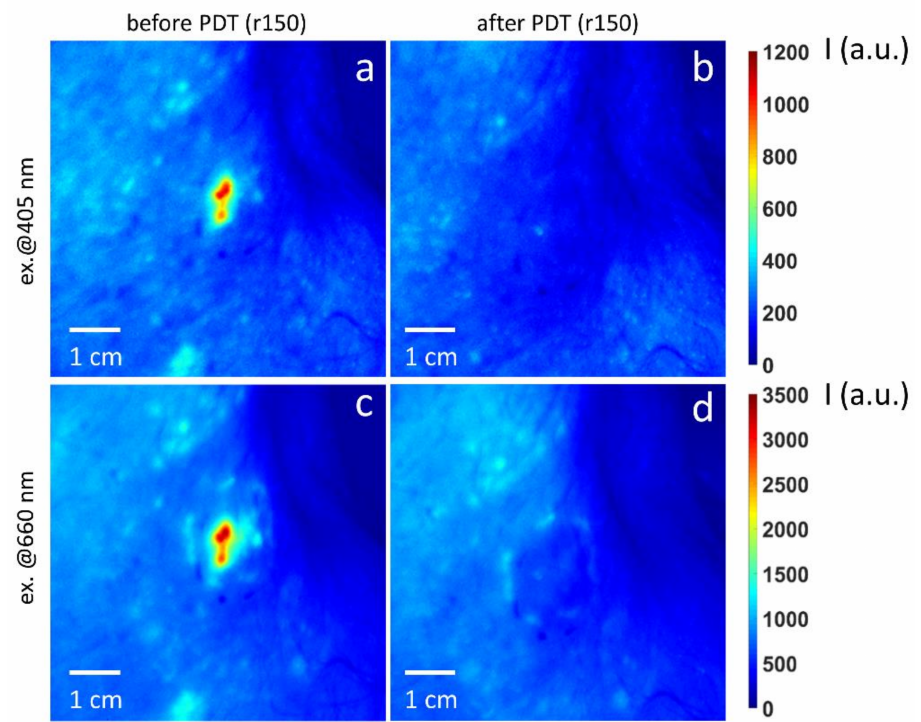
Figure 9. Typical fluorescence images of the BCC node site prior to ( a , c ) and after ( b , d ) the PDT procedure delivered at λ = 660 nm, with a dose of 150 J/cm 2 acquired at probing wavelengths of 405 ( a , b ) and 660 ( c , d )